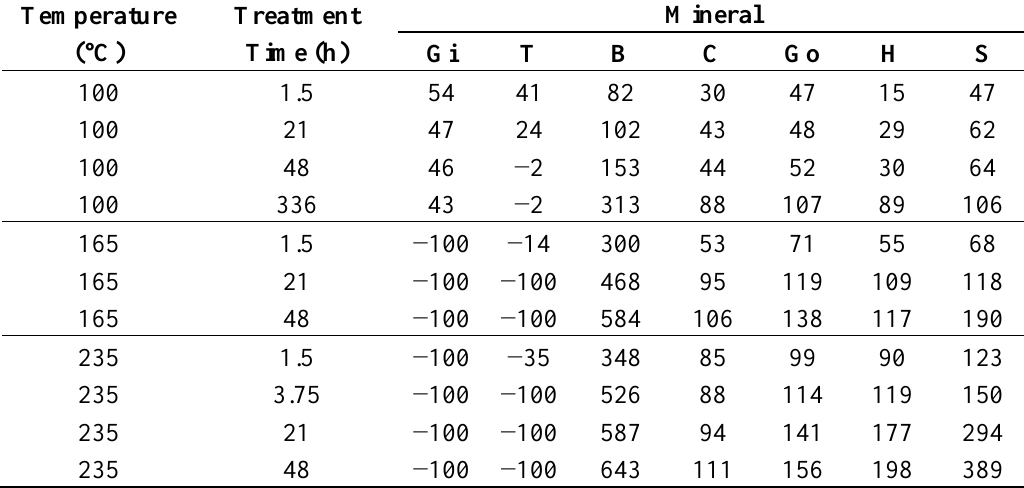
Table 2. Percentage change in mineral:anatase ratio during hydrothermal treatment of bauxite residue, relative to untreated bauxite residue. Ratio was calculated from primary peak areas of each mineral from synchrotron XRD scans. Mineral names are abbreviated as follows: Gi—gibbsite; T—tricalcium aluminate; B—boehmite; C—calcite; Go—goethite; H—hematite; S—sodalite. Mineral:anatase ratios of muscovite, anatase, and quartz did not indicate dissolution or precipitation in response to temperature or treatment